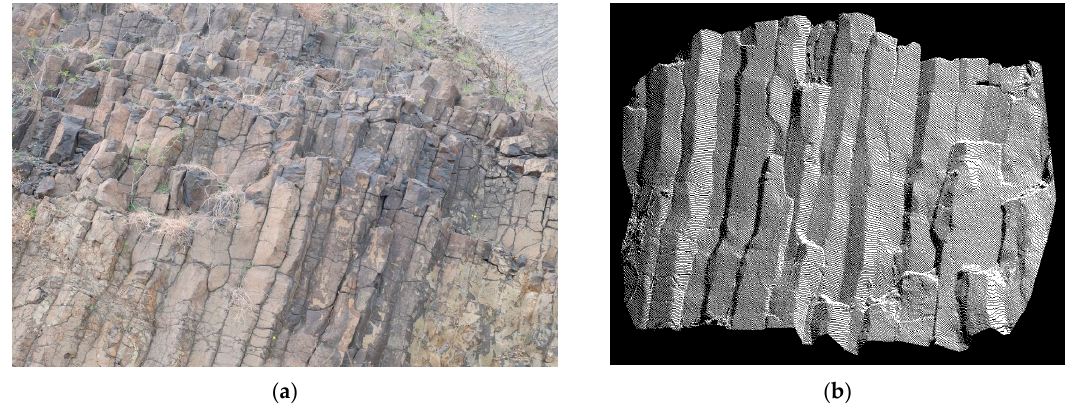
Figure 13. The image of the geological research area.